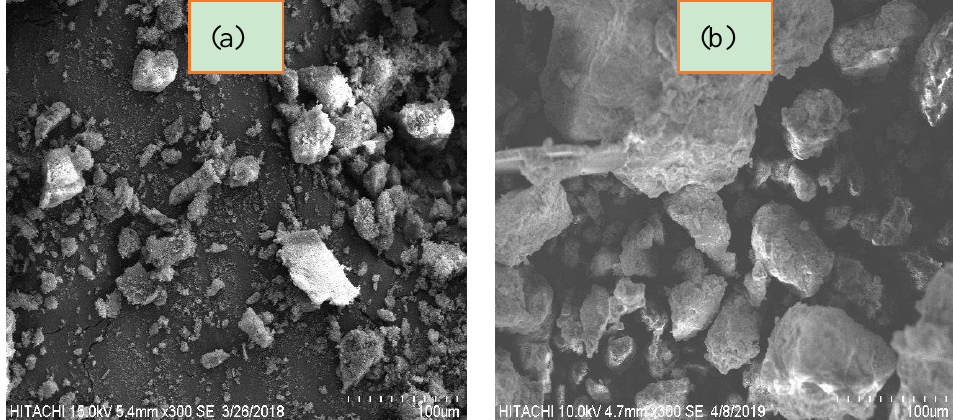
Figure 5. SEM micrographs of ( a ) T-PAA and ( b ) T-PAA loaded with MG and MB dyes.